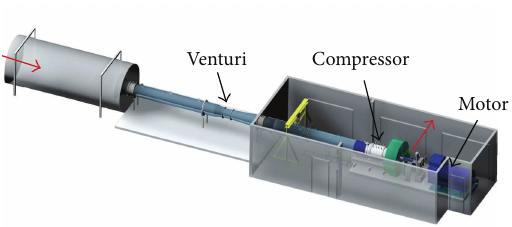
Figure 1: Layout of the Purdue 3-Stage Axial Compressor Research